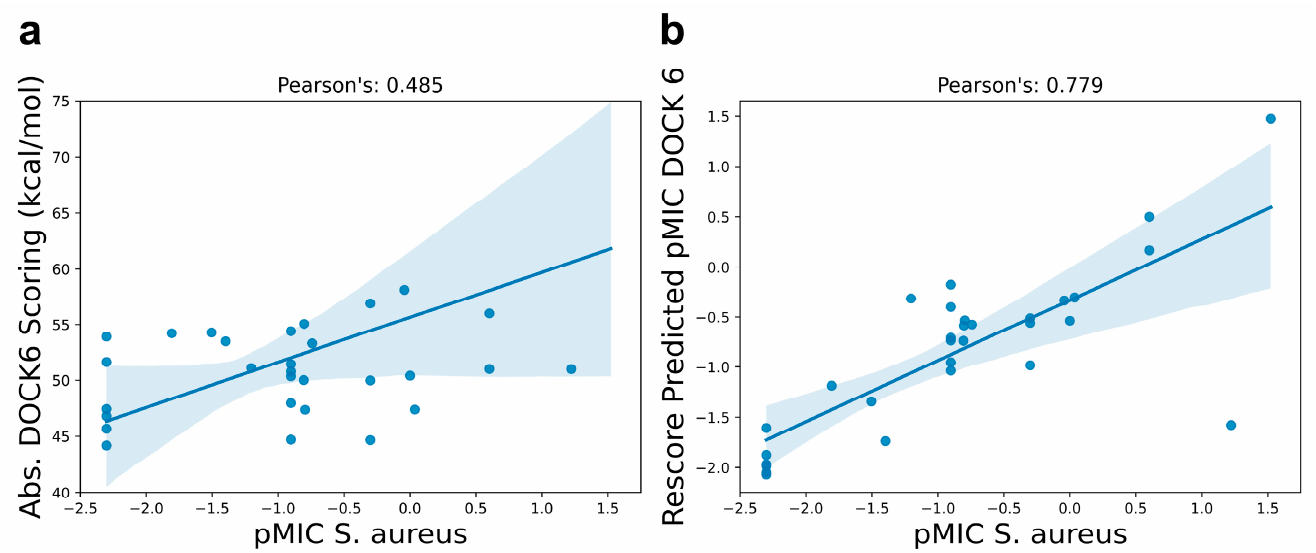
Figure 8. Scatter plots showing coefficient of Pearson’s correlation (r) between the experimental pMIC and predicted pMIC for test set compounds. ( a ) Absolute DOCK 6 score. ( b ) DOCK 6